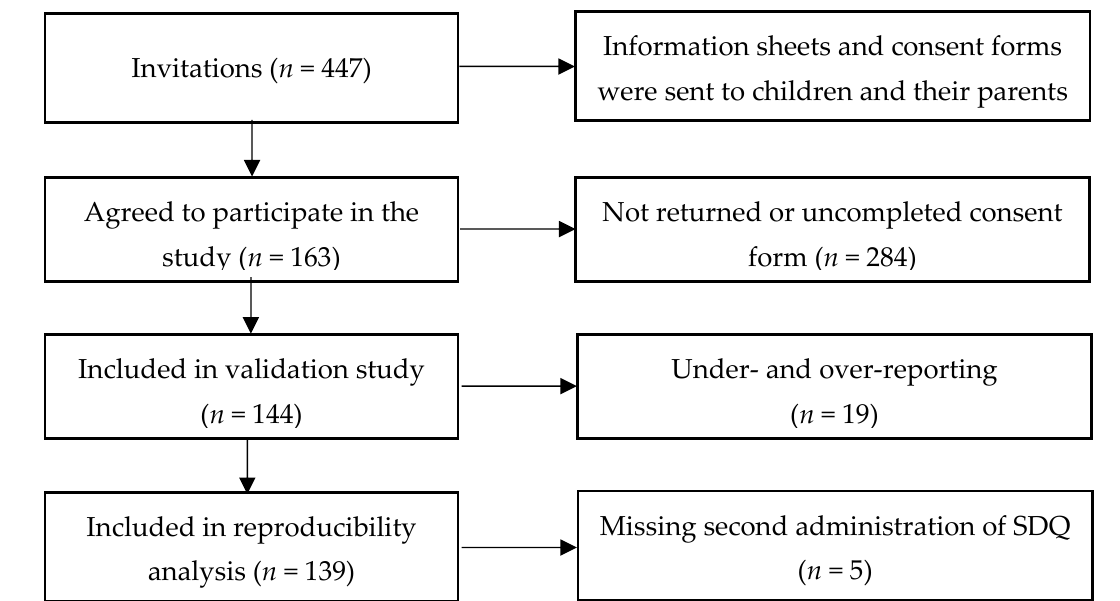
Figure 2. Participants in the validation study.